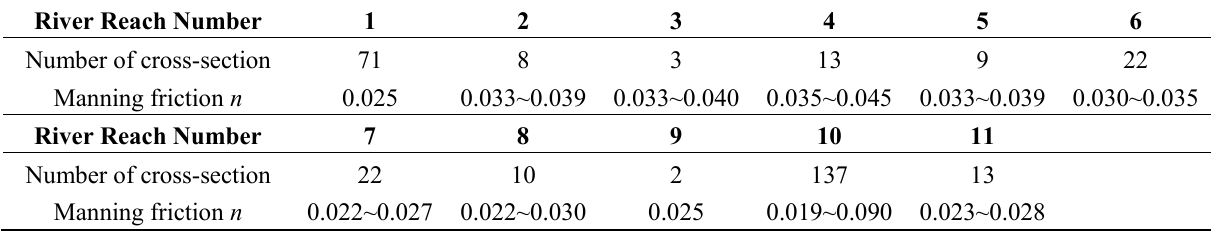
Table 1. Cross-sectional number of river reaches and Manning friction factor, n , used in the computational domain.